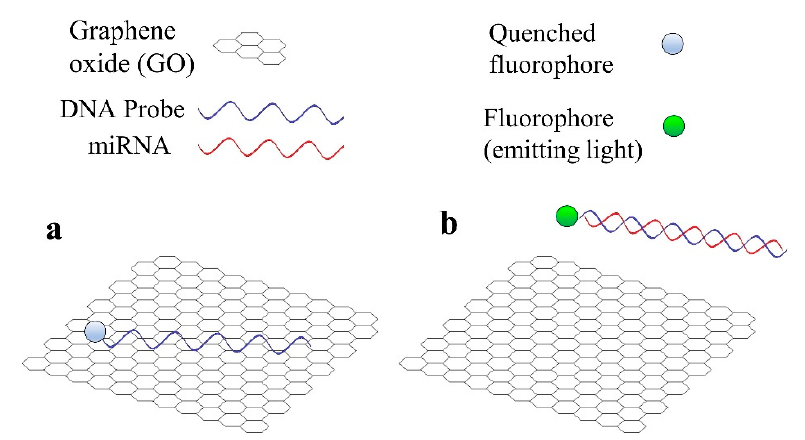
Figure 3. Basic operation principle of a fluorescent sensor for miRNA detection that employs graphene oxide (GO). ( a ) DNA probe is adsorbed by GO and the fluorophore is quenched. ( b ) miRNA hybridizes with DNA probe and both desorb from GO, the fluorophore emits light.